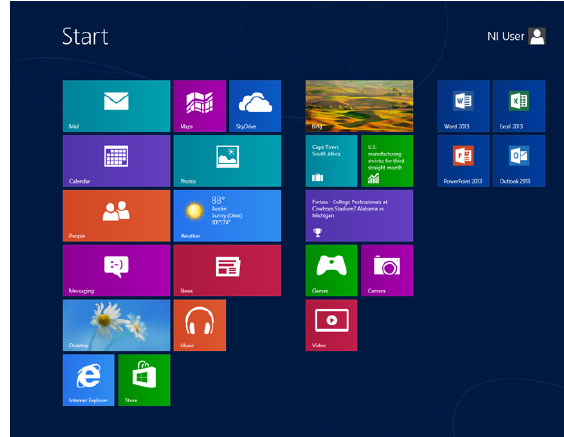
Figure 2. A screenshot of the main user interface in Microsoft’s Windows 8, which makes use of flat design, where boxes, buttons and icons represent applications and functions, but there is no correlation to physical objects in the real